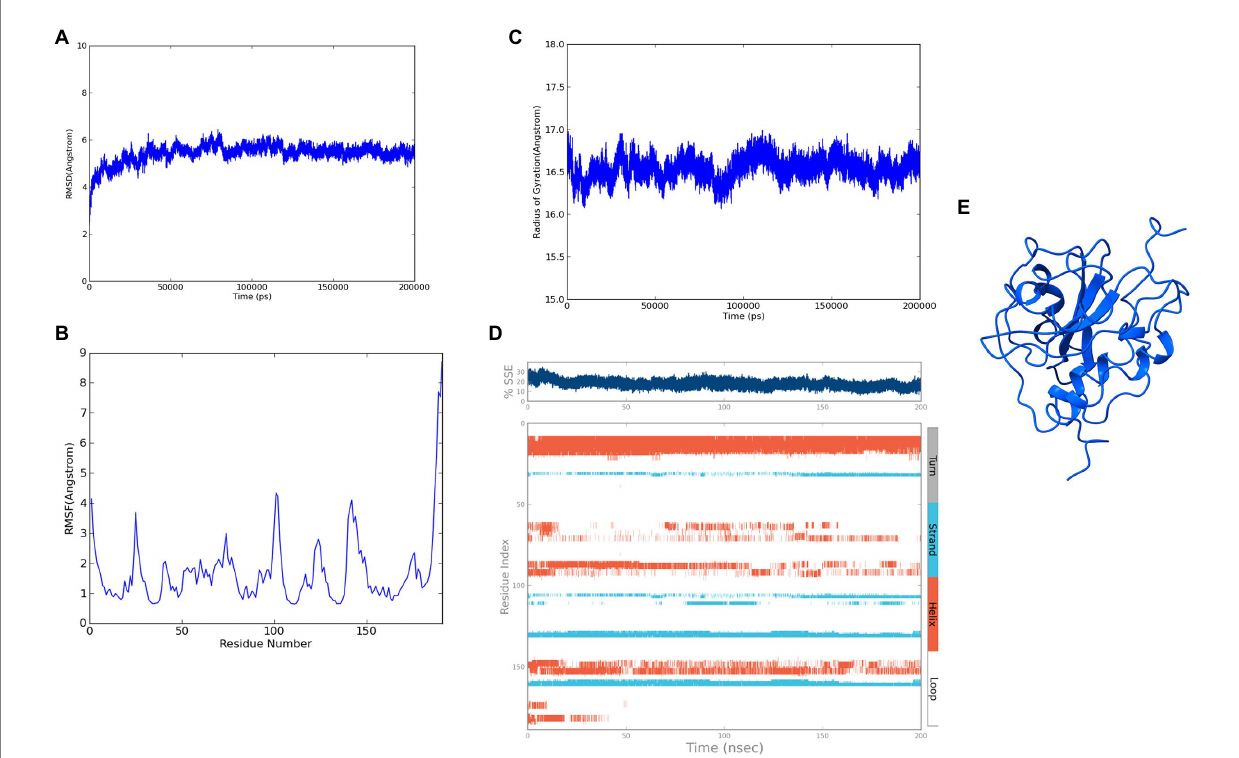
FIGURE 4 Molecular dynamics simulation trajectory analysis of ASP_Indie-C1: (A) Root Mean Square Deviation plot of ASP_Indie-C1 during 200 ns simulation period. (B) Root Mean Square Fluctuation plot of ASP_Indie-C1 during 200 ns simulation period. (C) Radius of gyration plot of ASP_Indie-C1 during 200 ns simulation period. (D) Secondary structure elements of ASP_Indie-C1 during simulation period (Orange-helices; Blue-strands; Gray-turns; White-loops). (E) Final frame structure of ASP_Indie-C1 after 200 ns